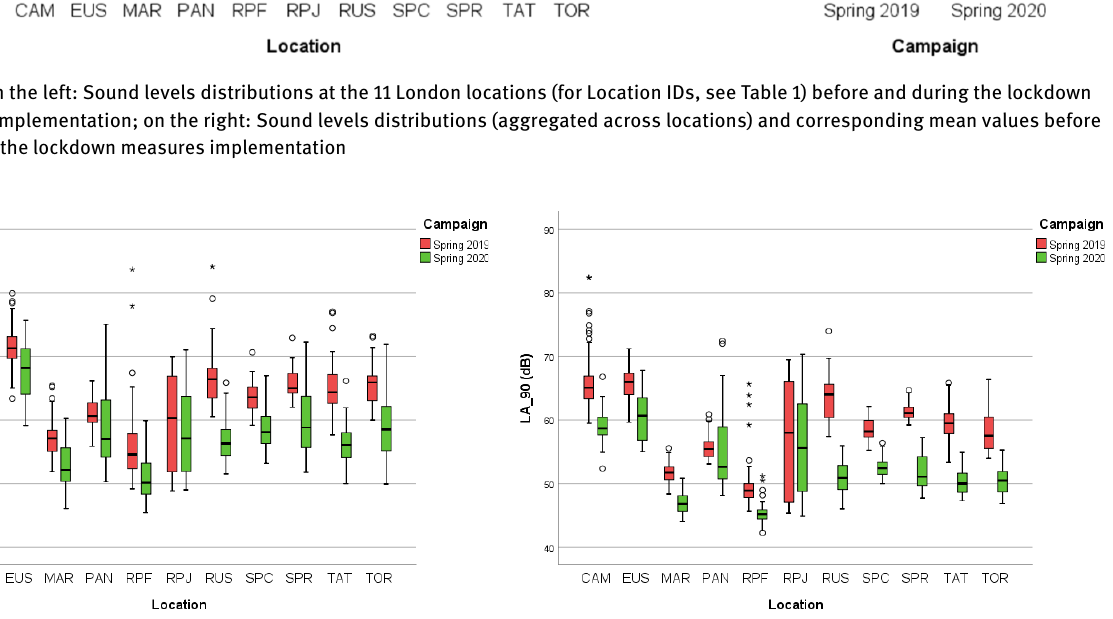
Figure 3: Sound levels distributions (90th percentile) at the 11 London locations (for Location IDs, see Table 1) before and during the lockdown measures